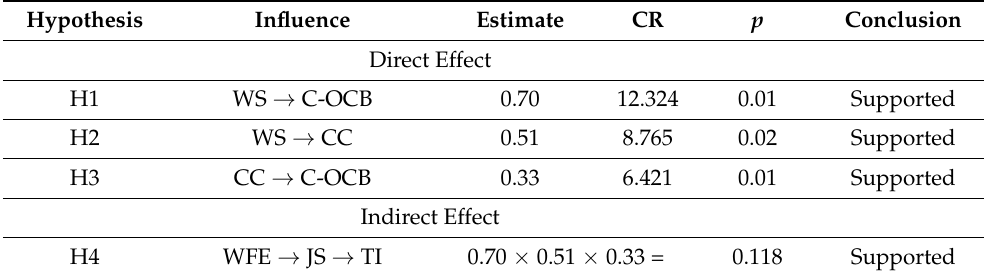
Table 3. Path relationship among